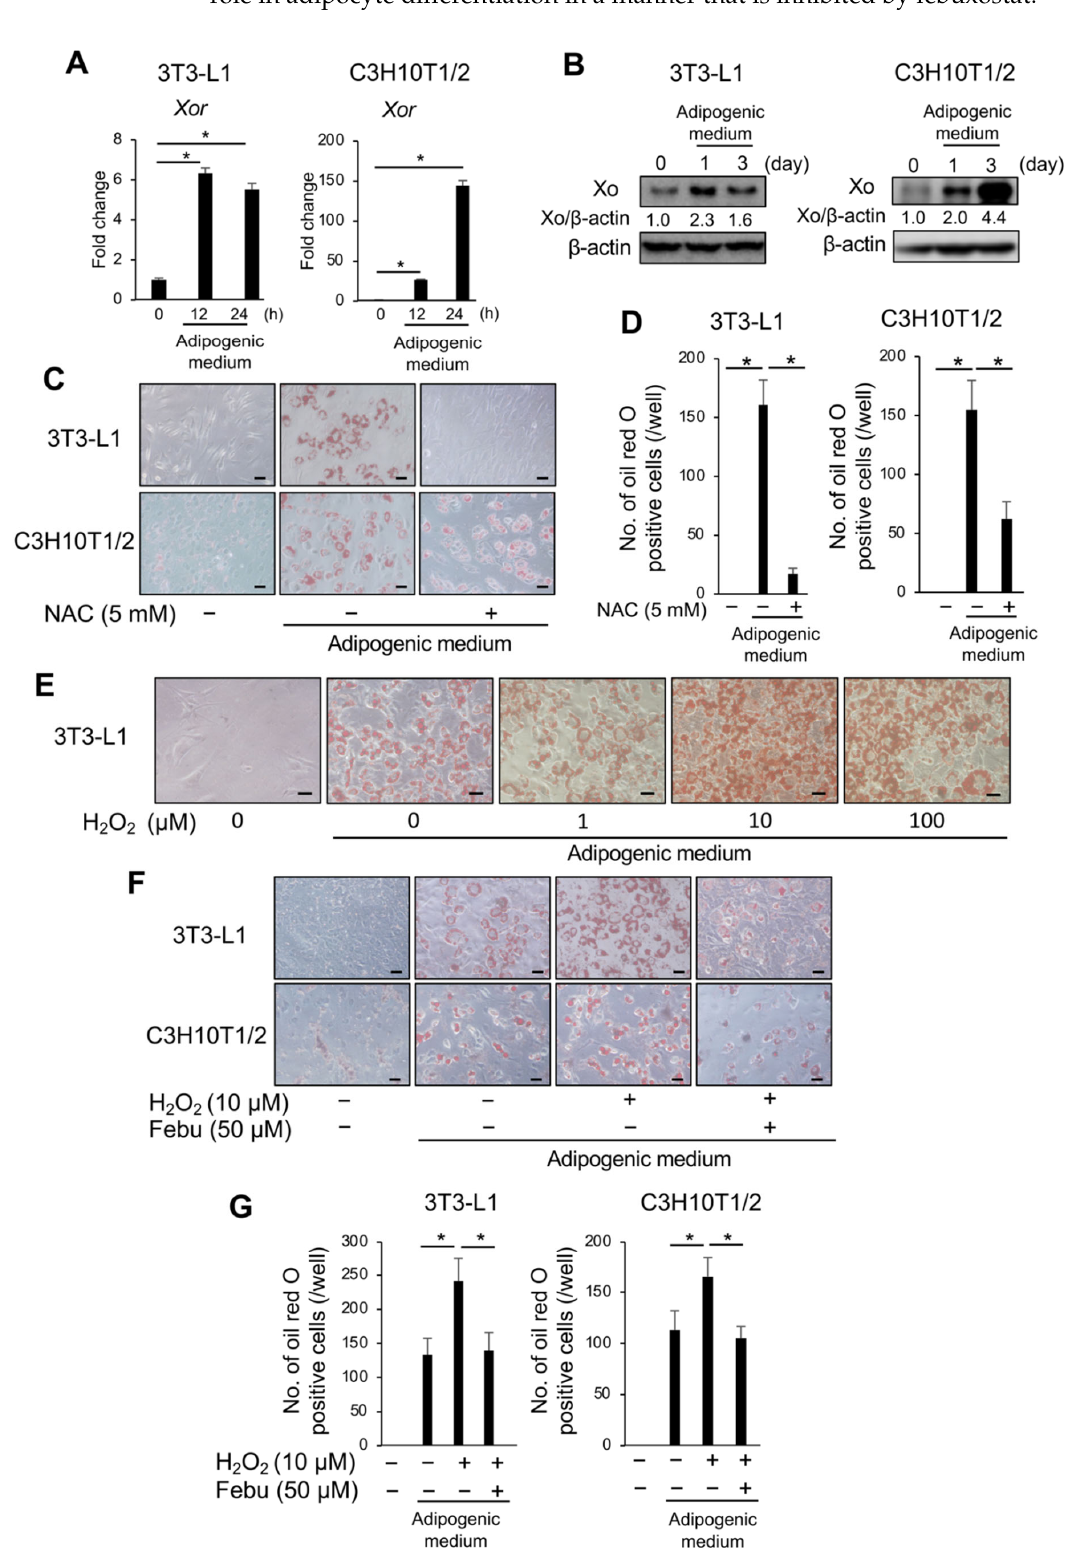
Figure 4. Xanthine oxidase (XO) is induced during adipogenesis, and Febuxostat inhibits ROS-induced excessive adipocyte differentiation. ( A ) 3T3-L1 and C3H10T1/2 cells were cultured in adipocyte differentiation medium. Xor mRNA expression was determined using real-time PCR. Gapdh served as an endogenous control to normalize each sample. Data are expressed as the mean ± SD ( n